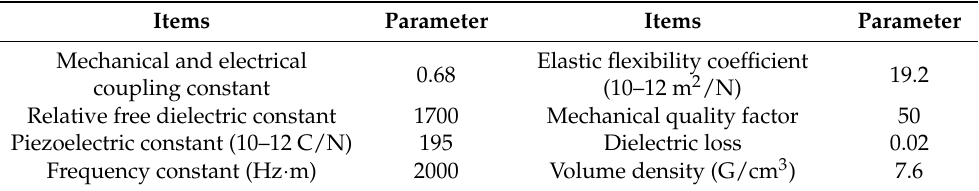
Table 1. Performance of YT-5L piezoelectric ceramics.